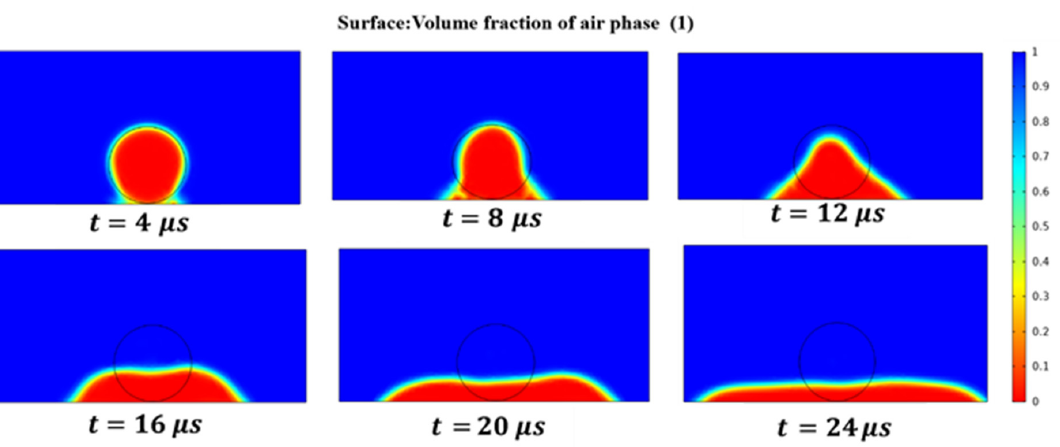
Figure 14. The spread of liquid Au on the surface of the platinum-tungsten alloy.